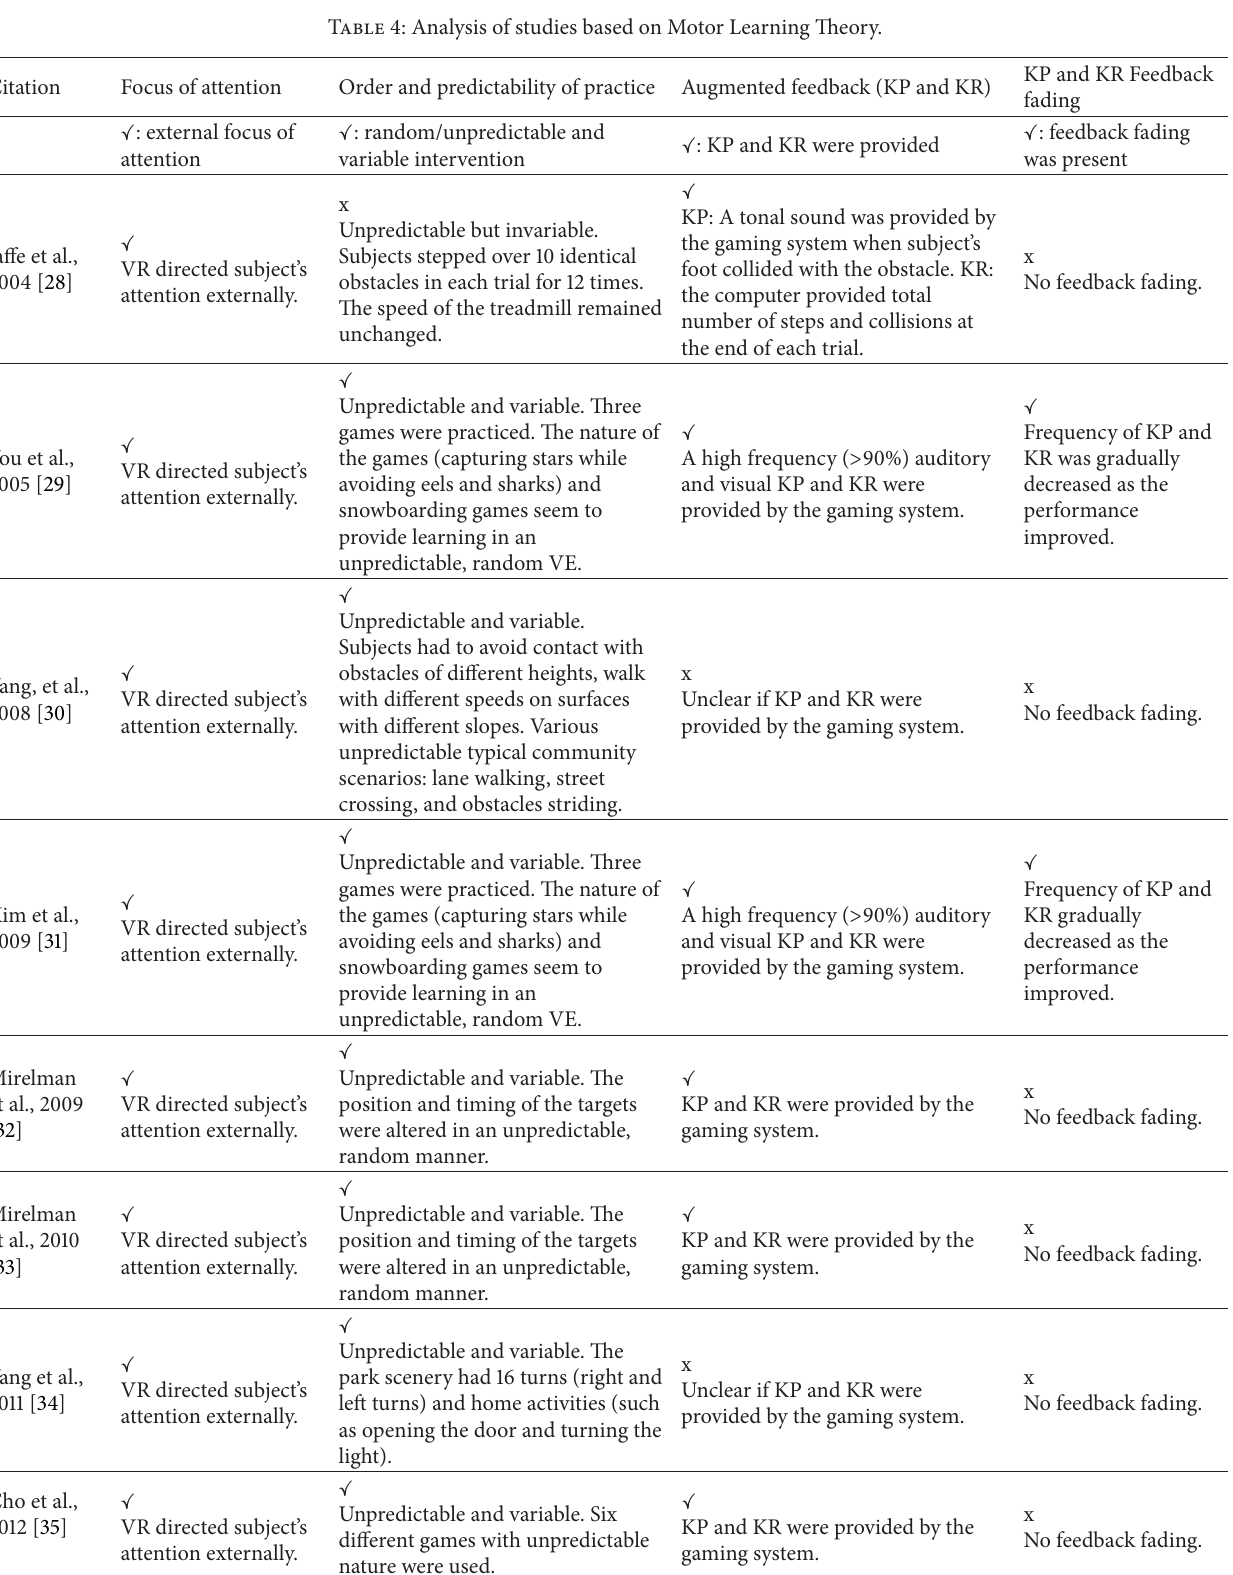
Table 4: Analysis of studies based on Motor Learning